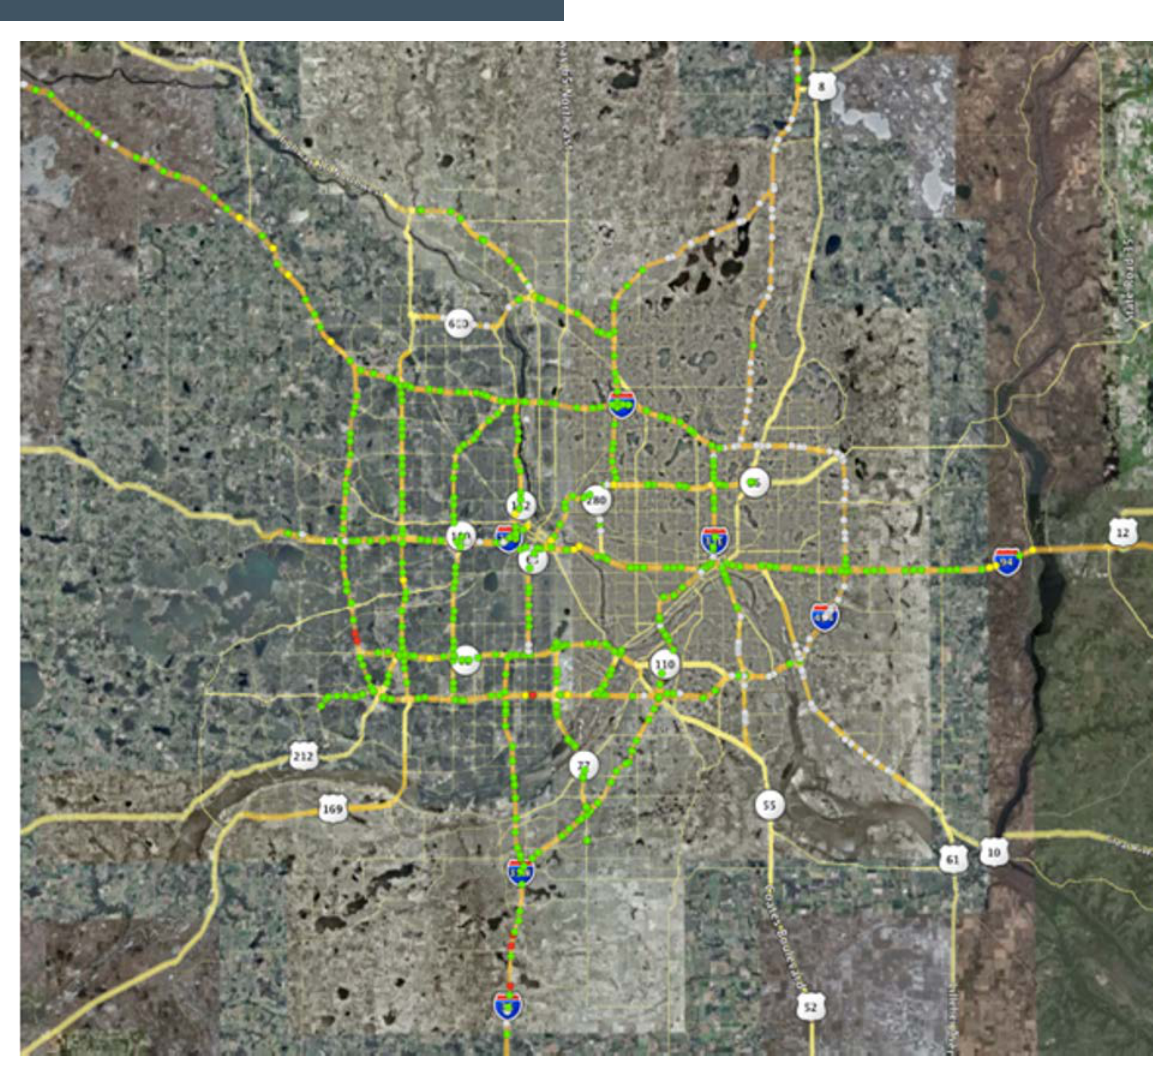
Figure 2. Twin City Metro Network System and Detector Locations